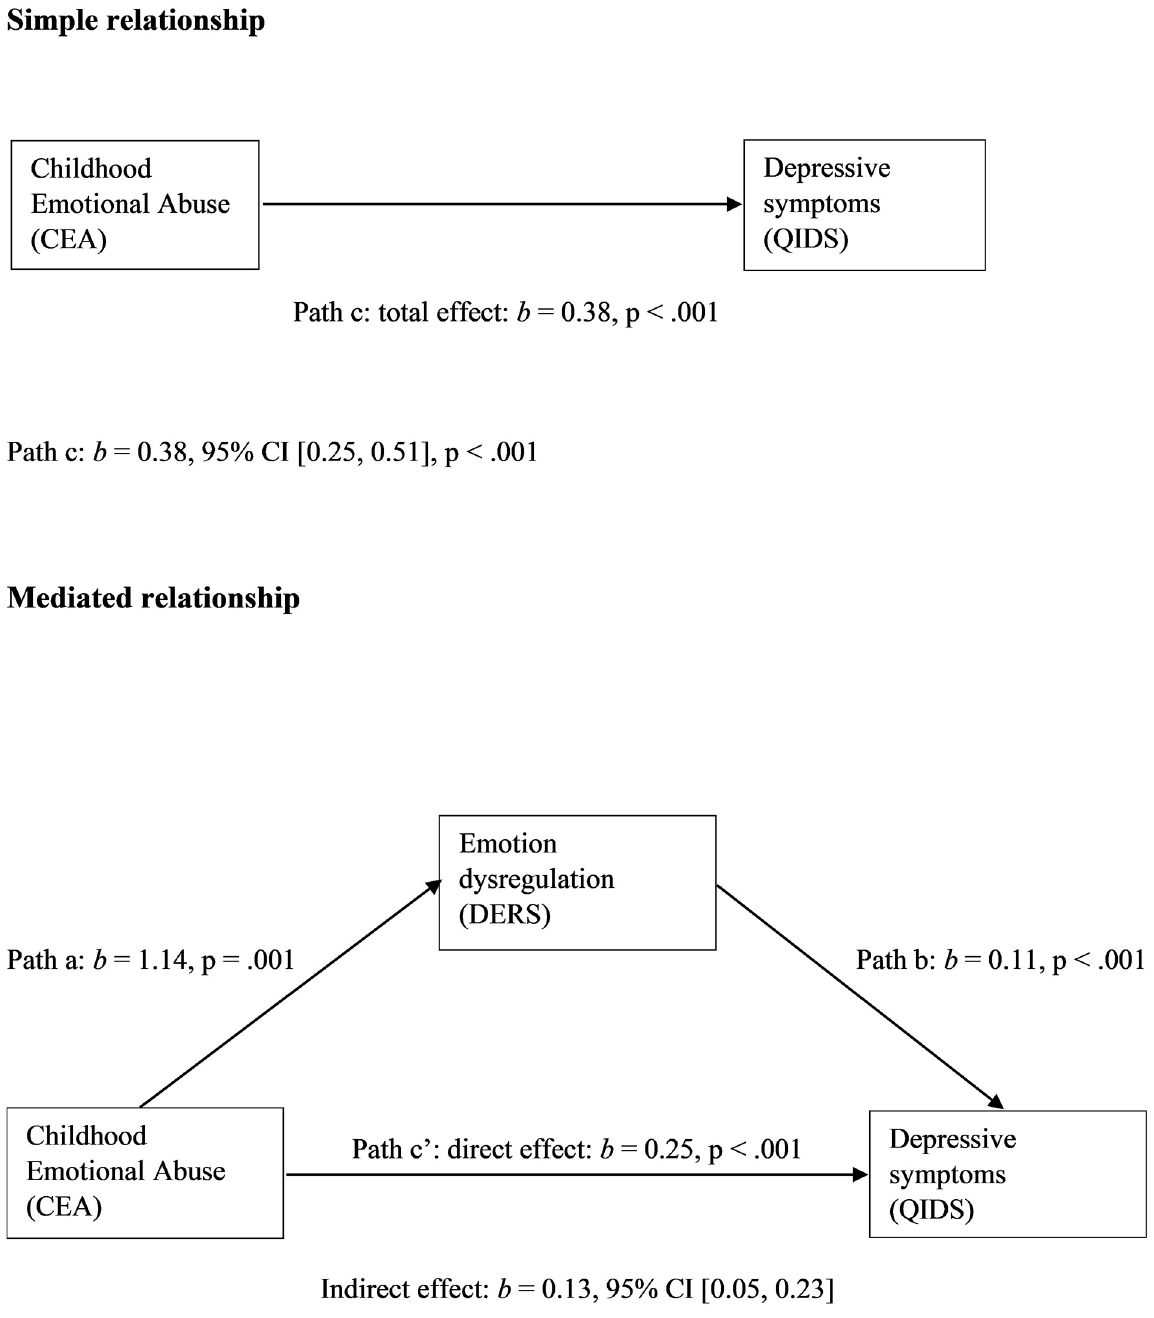
Fig 1. Model of childhood emotional abuse as predictor of depressive symptoms, mediated by emotion dysregulation.